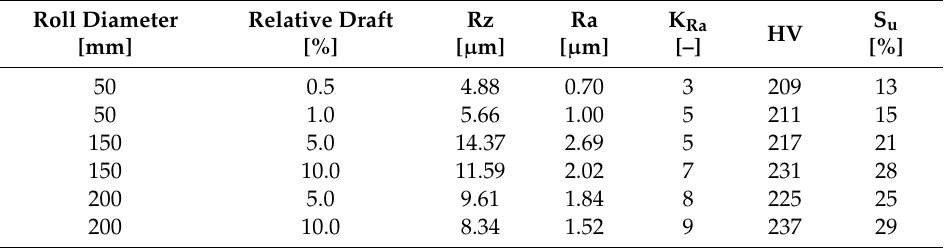
Table 2. The indicator decrease in surface roughness (K Ra ) and strengthening (S u ) of the Ni–5%Al alloy coatings after burnishing and rolling.